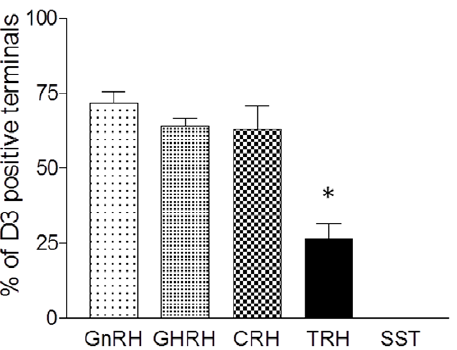
Figure 6. Quantification of D3 distribution in parvocellular axon terminals in the rat median eminence. (n=3; *P , 0.01 TRH vs. GnRH, GHRH, CRH and somatostatin (SST) by ANOVA followed by Newman-Keuls